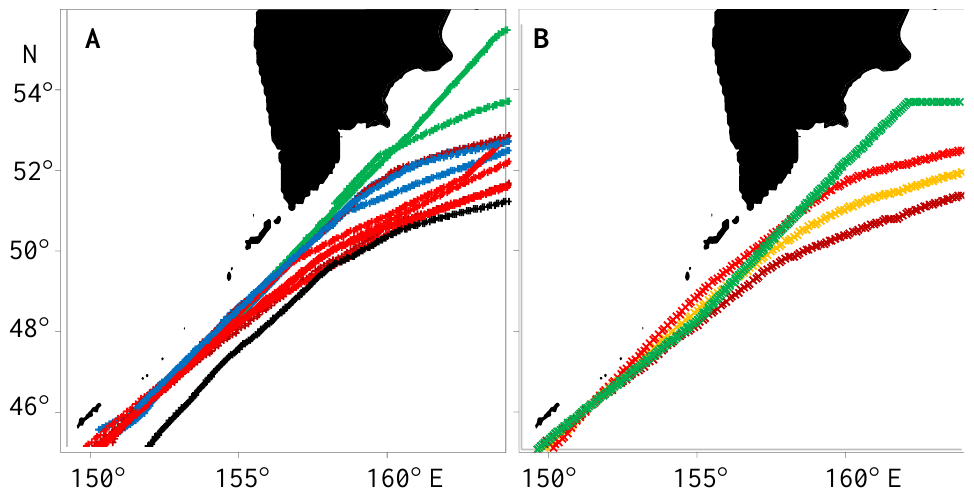
Figure 2. Underway measurement tracks. ( A ) — winter (red — 13 — 15.01.1998, 09 — 11.02.2000, 15 — 16.03.2000, 01 — 03.02.2018; brown — 30.01. — 01.02.1999, 14 — 16.03.1999; black — 27 — 28.01.2001; blue — 31.01. — 02.02.2003, 28 — 29.02.2020; green — 16 — 18.01.2013, 16 — 18.02.2013), ( B ) — spring – summer (light brown — 13 — 15.06.1995, dark brown — 16 — 18.07.1998, red — 01 — 03.07.1999, green —